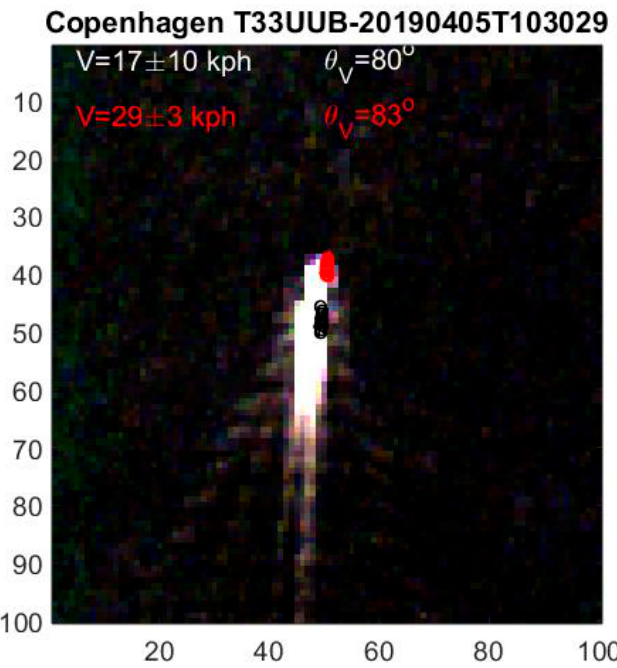
Figure 8. Ship with up to a dozen observable Kelvin waves in its wake.